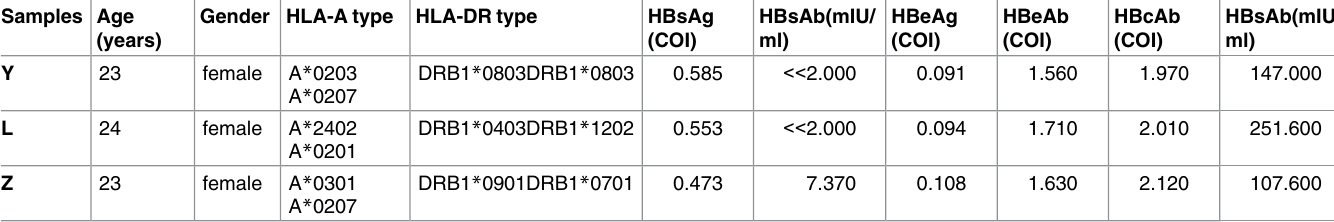
Table 2. Demographical and clinical characteristics of 3 volunteers.